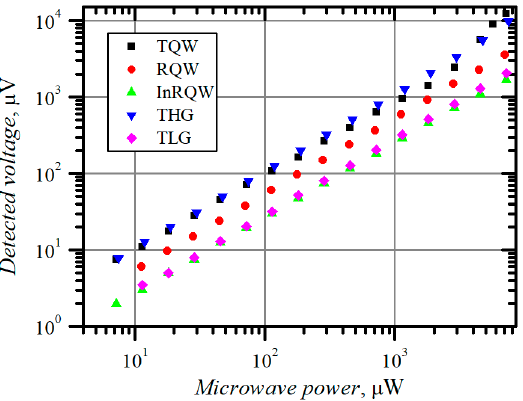
Figure 4. Voltage–power characteristics of planar, asymmetrically shaped MW diodes measured at f = 30 GHz in the dark.